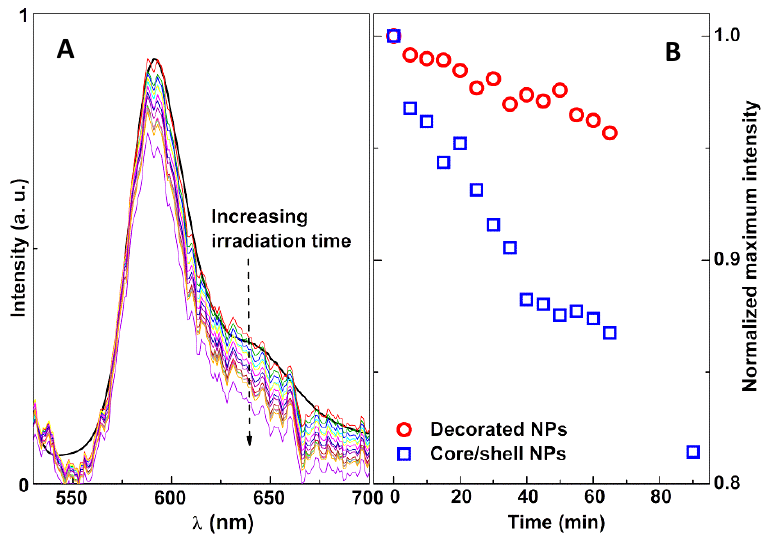
Figure 14. ( A ) Fluorescence spectra of Rhodamine B-DOPE in magnetoliposomes containing nickel ferrite / gold core / shell nanoparticles following several irradiation times (5-min steps, maximum: 90 min). The black line curve is the reference spectrum obtained in a commercial fluorimeter. ( B ) Variation of the normalized maximum intensity of Rhodamine B fluorescence with irradiation time, for magnetoliposomes containing both types of magnetic / plasmonic nanoparticles.